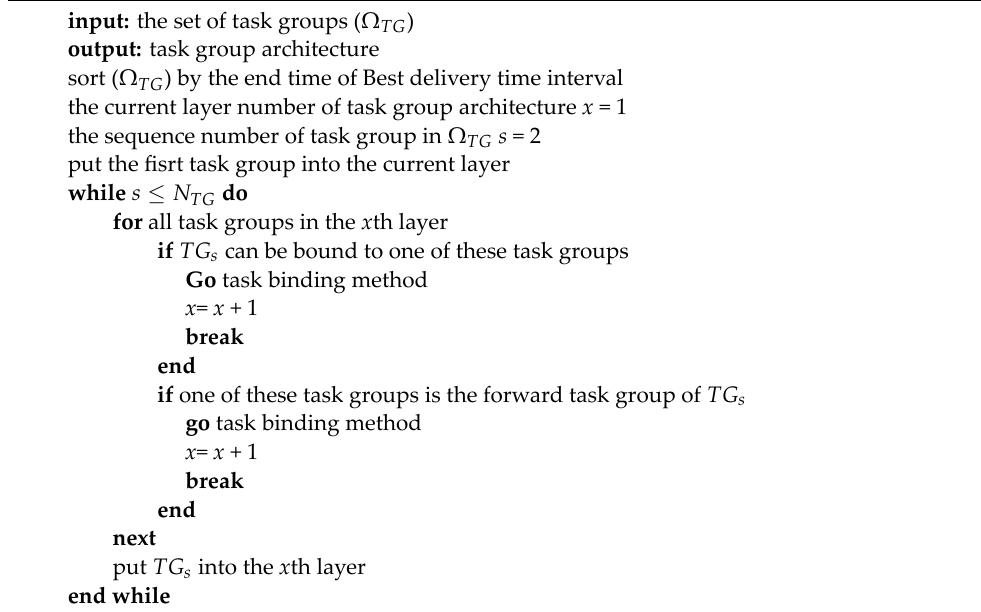
Algorithm 1. Task group layering strategy pseudo